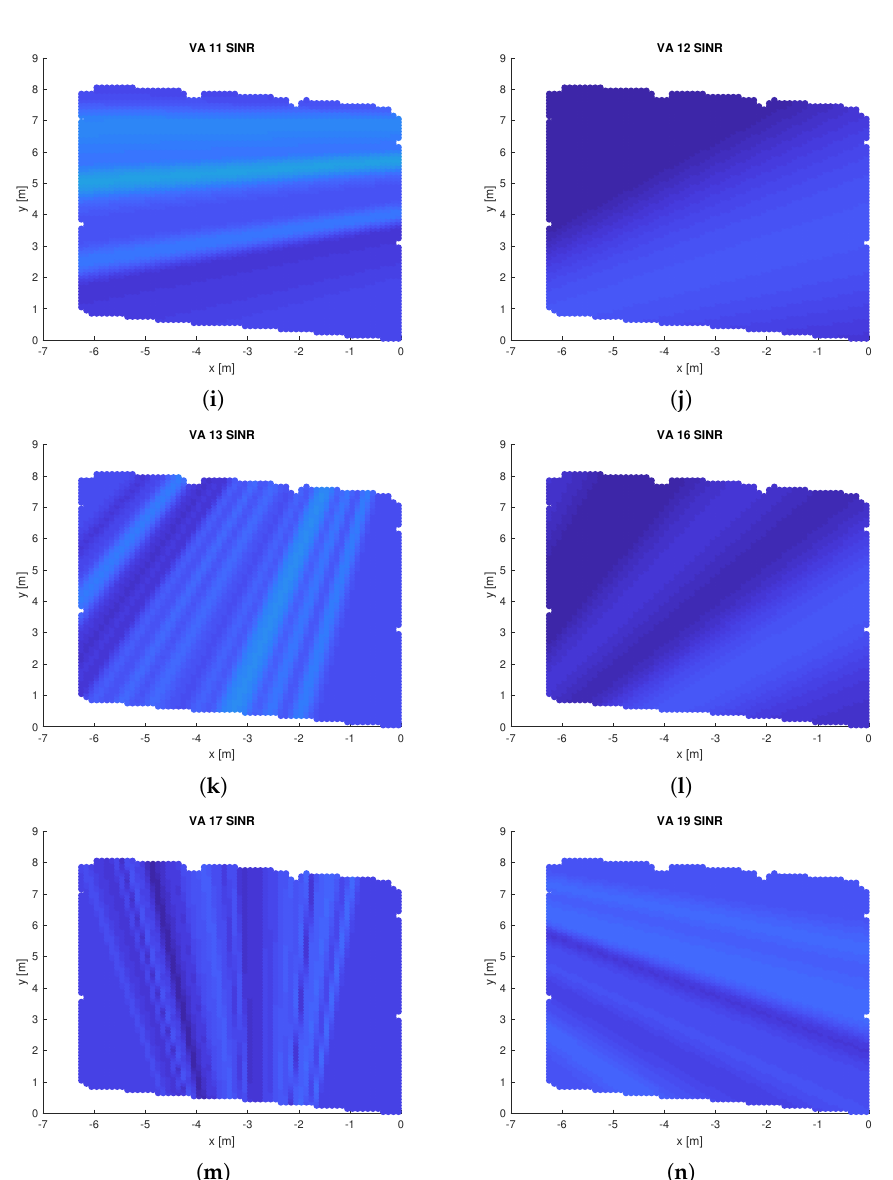
Figure 7. Predicted SINR for the whole floor plan for various links: ( a ) LOS, ( b ) reflection on EPB, ( c ) reflection on WW, ( d ) reflection on on south part of the room, ( e ) reflection on the north part of the room, ( f ) double reflection on EPB then WW, ( g ) double reflection on WW then SW, ( h ) double reflection on EPB then NGW, ( i ) double reflection on WW then EPB, ( j ) double reflection on WW then SW, ( k ) double reflection on SW then GW, ( l ) double reflection on SW then WW, ( m ) double reflection on NGW then SW, ( n ) double reflection on NGW then WW. SINR is obtained by applying GPR on the CIRs obtained from measurement at 595 points along the trajectory, as shown in Figure 1. The same dB scale is used in all sub